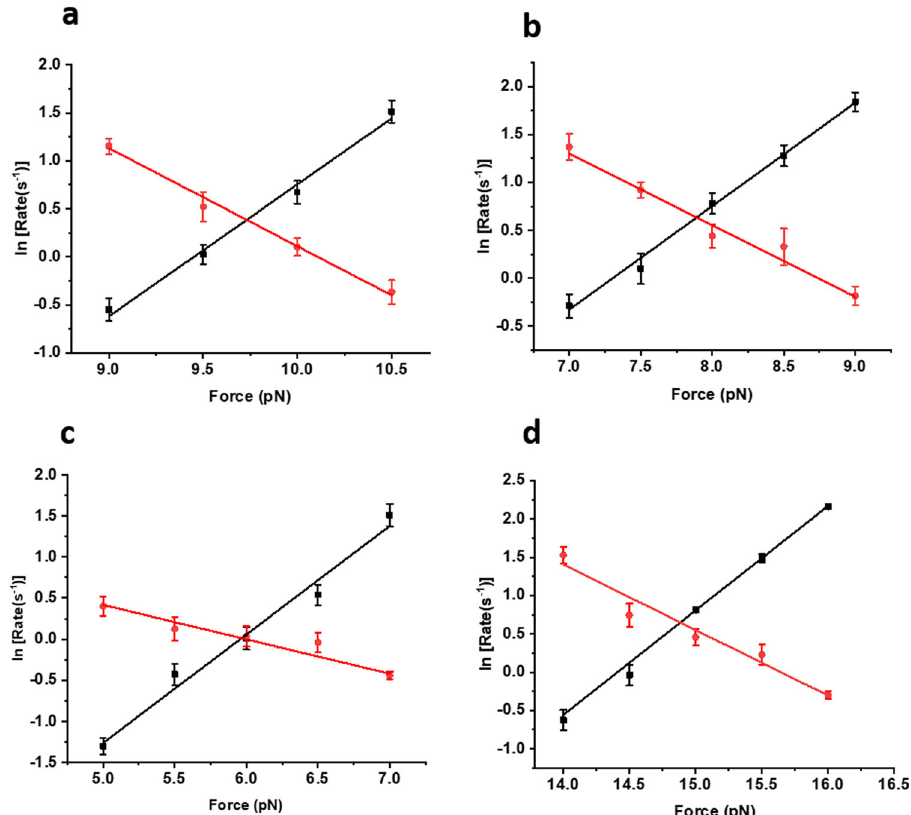
Fig. 4 Unfolding and refolding rates of talin domain. a Unfolding (black) and refolding (red) rates in the absence of any chaperones (control) are plotted as a function of force. b Effect of DnaJ on unfolding and refolding rates. Unfolding (black) and refolding (red) rates of talin in the presence of 1 µ M DnaJ. Data points are calculated using more than six protein molecules. Error bars are the relative errors of log. c Refolding (red) and unfolding (black) rates of R3-IVVI at different forces, in the presence of 3 µ M DnaK. Data points are calculated using more than fi ve protein molecules. Error bars are the relative error of the log. d Unfolding (black) and refolding (red) rates of R3-IVVI are plotted against the force, in the presence of 60 µ M DsbA. Data points are calculated using a minimum of three molecules per force. Error bars are the relative errors of log. Table 1 Unfolding kinetics parameter modulated by chaperones and their different nucleotide states.